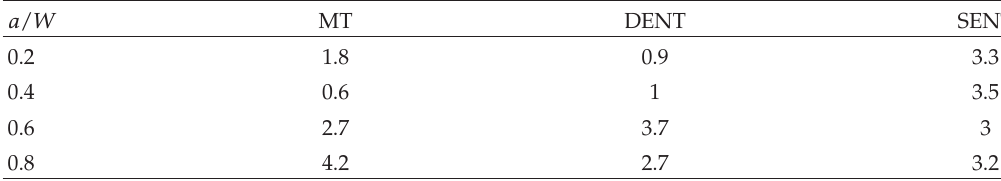
Table 5: Percentage of errors of stress intensity factors for surface loaded